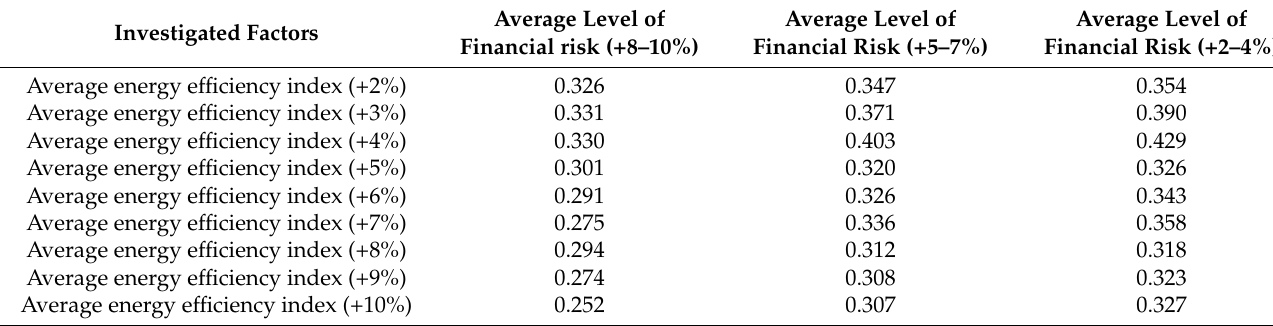
Table 1. Initial data for the analysis of variance of the impact of financial risk and energy efficiency on the level of energy supply to socially vulnerable groups of EECCA countries’ population